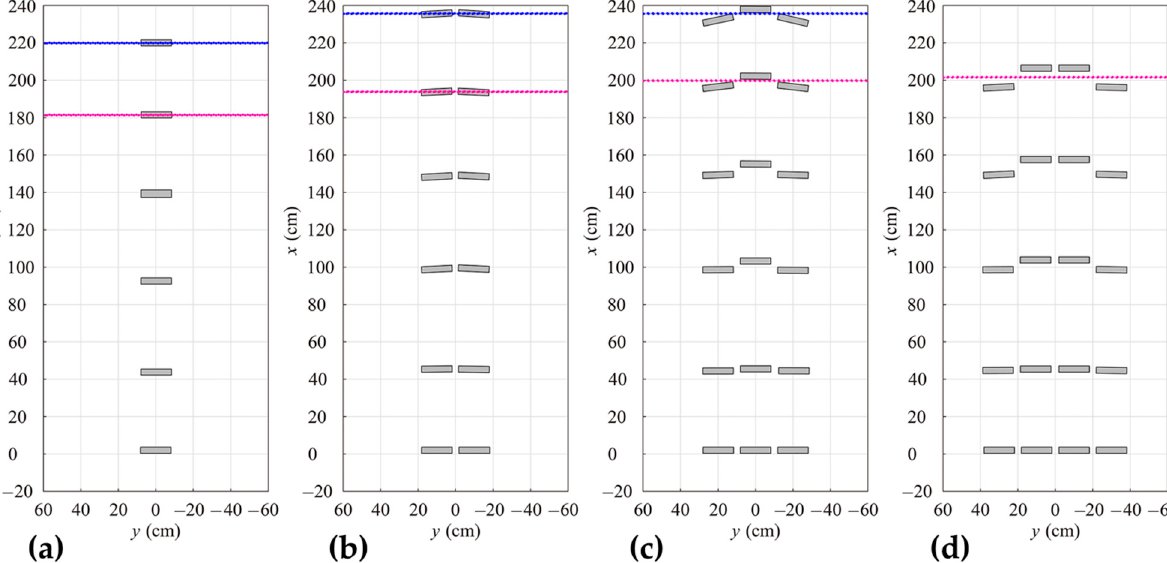
Figure 13. Location of the entire container group after starting the drift at a 0.4 s interval. Configu- rations ( a ) 11190; ( b ) 12190; ( c ) 13190; ( d ) 14190; ( e ) 41190; ( f ) 42190; ( g ) 43190; and ( h ) 44190. Figure 14 compares the location of the center of gravity in the x direction for the entire container group (increasing number of N y container specimens with the same initial ar- rangements of N x and N z ) at 0.1 s after starting the drift. It shows that an increased number of container layers ( N z = 2) corresponds to a decrease in the wave-flow behavior of the center of gravity of the whole group in the x direction, as well as smaller drifting flow motion than when N z = 1. For trajectories observed in Figure 14b–d, a reduction of approx- imately half of the longitudinal displacement of the container was measured in compari- son with the one-layer cases of Figure 11b–d. Aside from the increase in the total container weight, the heavier container stack increases the force area, which accounts for the de- crease in total container arrangement motion. However, as N y increases, the drift flow motion of the center of gravity of the entire group will accelerate (except for N x = 1). This